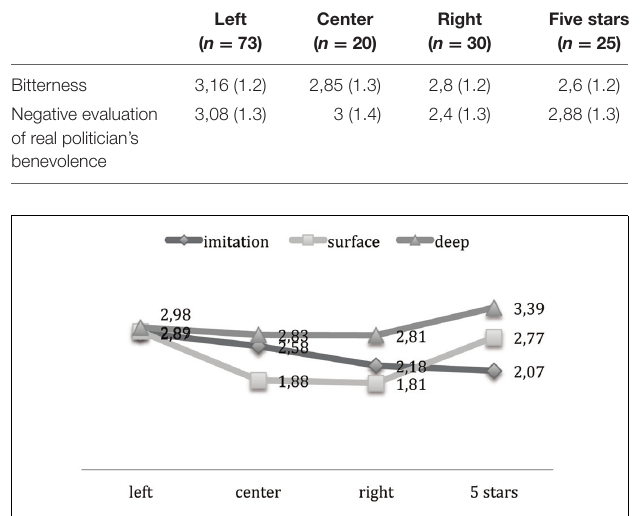
FIGURE 4 | Political orientation ∗ conditions on politician’s negative evaluation.